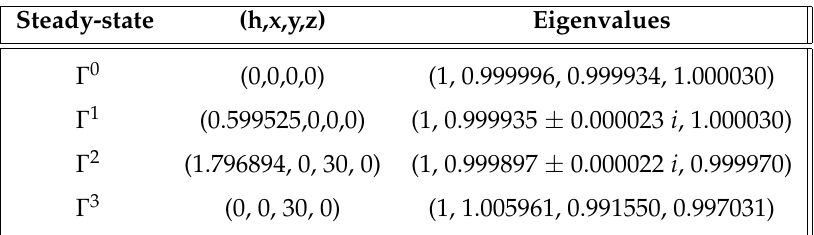
Figure 1: the eigenvalues characterized by the same symbol are relative to the same steady-state. Since all the four steady-states have a unitary eigenvalue, following the Definition 3 they are nonhyperbolic. Table 1. Steady-states and eigenvalues of the